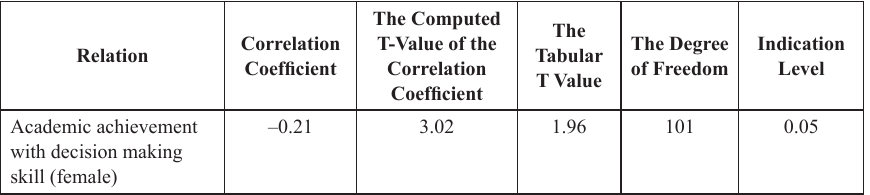
Table 9. Correlation coefficients between decision-making skill & academic achievement and the significance of correlation when at research